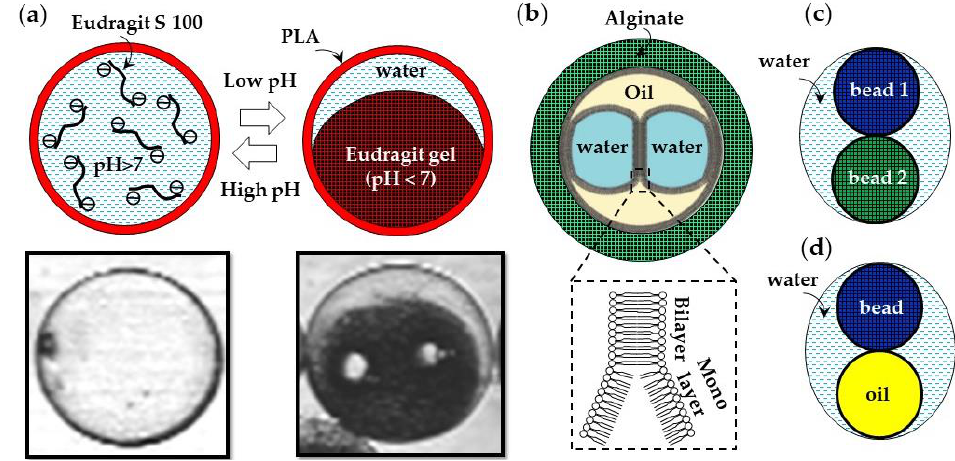
Figure 33. Composite microgels prepared in microfluidic devices. ( a ) pH-responsive Eudragit S100 microgel encapsulated within a Nile Red-labelled poly(lactic acid) (PLA) shell. At pH > 7, the core is a colorless liquid due to hydrophilic character of charged Eudragit chains. At pH < 7, the core is a red-colored solid gel due to diffusion of Nile red from the shell. A small amount of water was expelled from the gel after the sol–gel transition [127]. ( b ) Droplet interface bilayers (DIBs) formed in an oil phase and encapsulated within an alginate shell [128]. ( c ) Gel beads from two distinct polymers encapsulated in a single water drop using a microfluidic particle zipper [129]. ( d ) A single gel bead and oil droplet encapsulated within a larger water droplet [130].